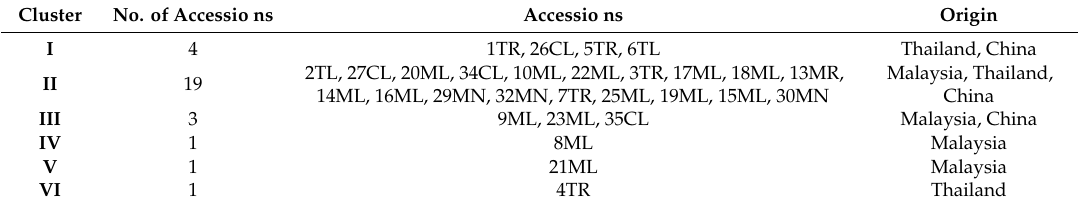
Table 7. List of clusters of 29 eggplant accessio ns according to cluster